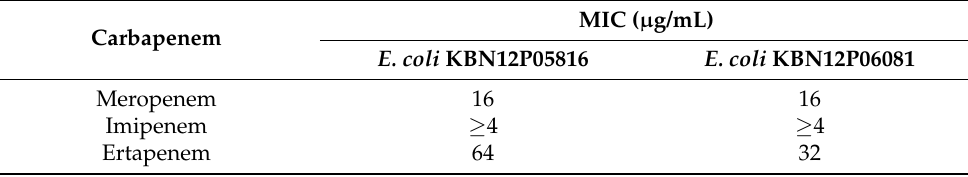
Table 1. Minimum inhibitory concentration (MIC in µ g/mL) of carbapenems against clinically isolated E. coli